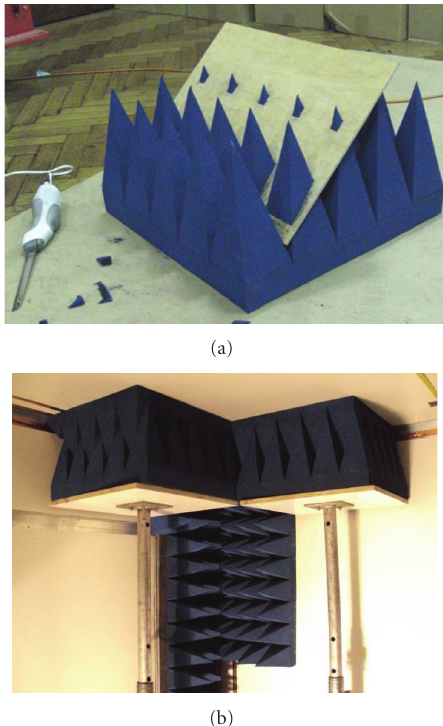
Figure 26: (a) Indicative use of mitre-cutting template and recommended cutting tool. (b) Recommended means of supporting ceiling panels while (3M 90) adhesive